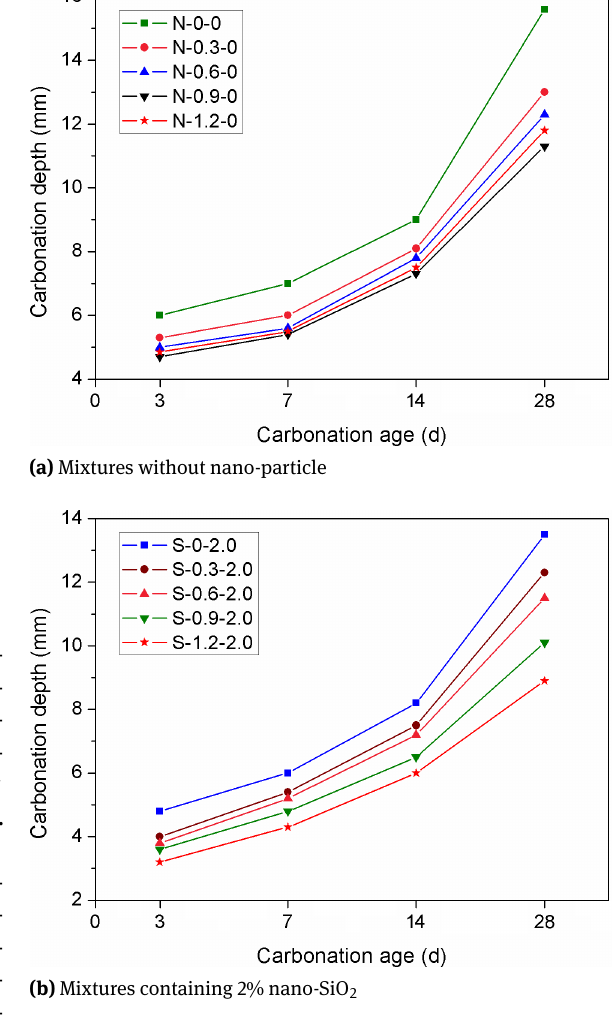
Figure 2: Effect of PVA fiber on carbonation depth